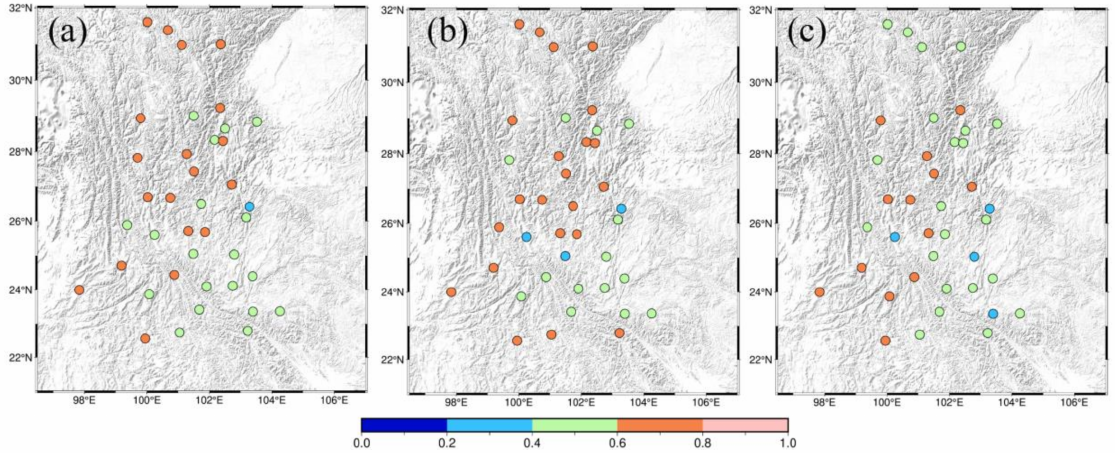
Figure 4. Correlation between GNSS vertical time series and HYDL time series provided by EOST